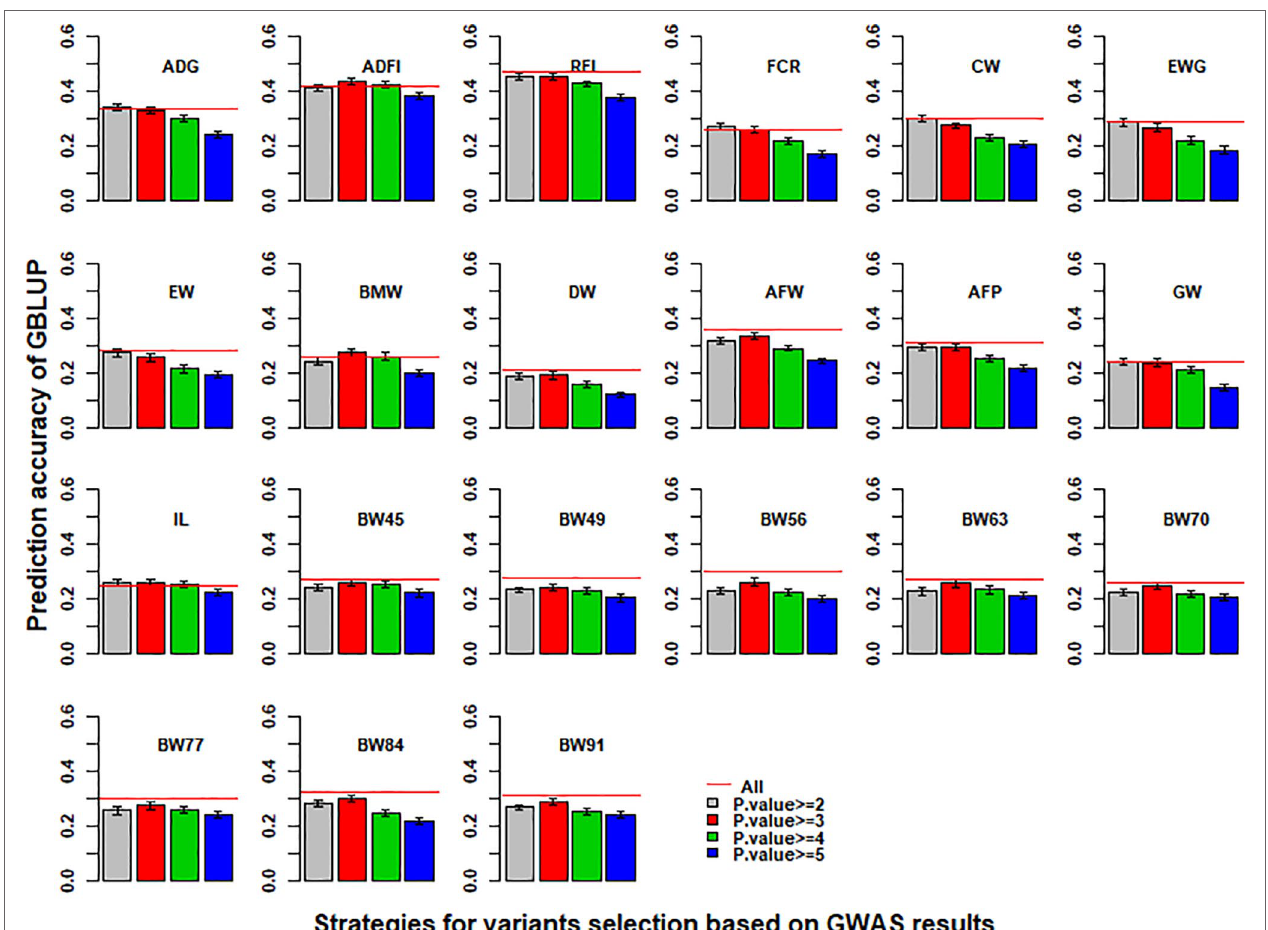
FIGURE 3 | Impact of pre-selected variants on the predictive ability of GBLUP using imputed WGS data. Different p -value cutoffs from 2 to 5 were used to select variants from imputed WGS data based on GWAS results for GBLUP. The red line was the prediction accuracy of GBLUP with all markers of imputed WGS data. The predictive ability was assessed by the Pearson correlation between the predicted genetic values and the observed phenotypes corrected for fixed effect(s) per trait. These traits were average daily gain (ADG), average daily feed intake (ADFI), residual feed intake (RFI), feed conversion ratio (FCR), carcass weight (CW), breast muscle weight (BMW), eviscerated weight with giblets (EWG), eviscerated weight (EW), drumstick weight (DW), abdominal fat weight (AFW), abdominal fat percentage (AFP), gizzard weight (GW), intestine length (IL), body weight in 45 days (BW45), body weight in 49 days (BW49), body weight in 56 days (BW56), body weight in 63 days (BW63), body weight in 70 days (BW70), body weight in 77 days (BW77), body weight in 84 days (BW84), and body weight in 91 days